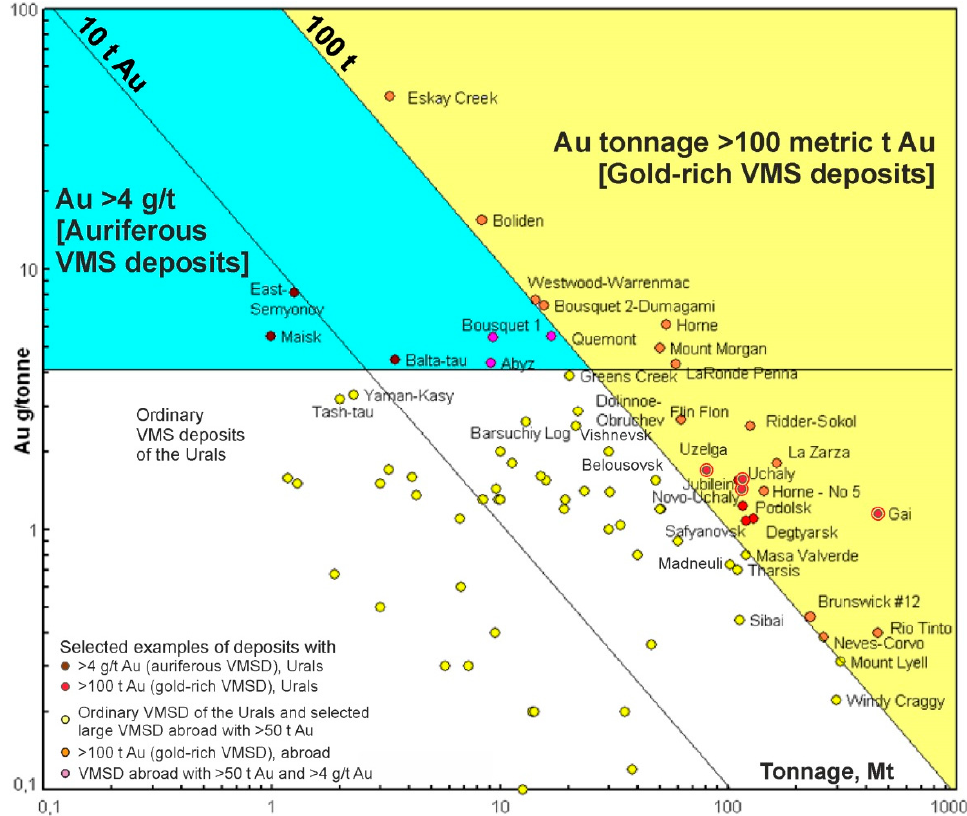
Figure 3. Parameters of VMS deposits of the Urals, in terms of ore and gold tonnage, and their comparison with major Au-bearing VMS deposits of the world; red circles with a red ring—deposits under consideration. Design and parameters for other deposits were adapted from the review in [84].